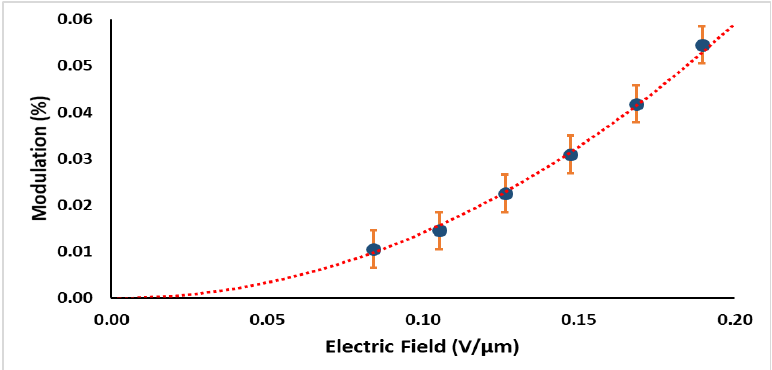
Figure 5. Quadratic electro-optic modulation data for different applied electric fields, for a particle diameter of about 15 nm.